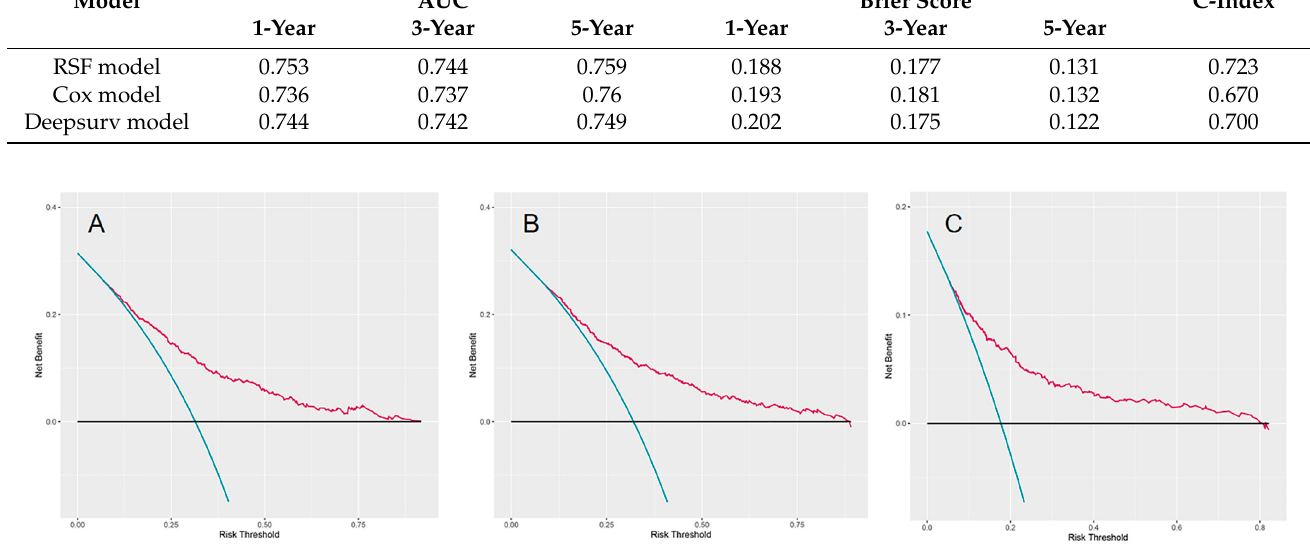
Table 2. The models’ performance in the test set. Figure 3. The decision analysis curves of RSF model. ( A ) The one-year decision analysis curve of RSF model. ( B ) The three-year decision analysis curve of RSF model. ( C ) The five-year decision analysis curve of RSF model. In the decision analysis curve, the x -axis represented the threshold probability while the y -axis represented the clinical net benefits. The blue line in the DCA plot reflects the strategy of “assume all patients have received the assessment of the RSF model”, while the horizontal black line demonstrates the strategy of “assume no patient has received the assessment of the RSF model”.